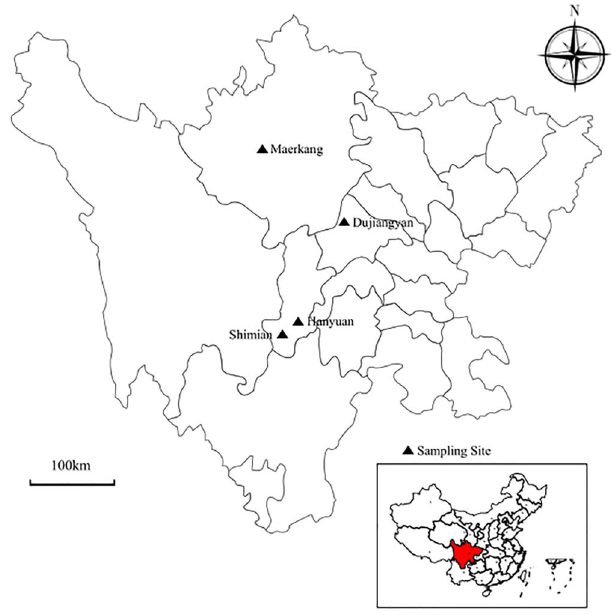
Figure 1. Locations of the sampled sites ( fi lled triangle) in Sichuan Province, Southwestern